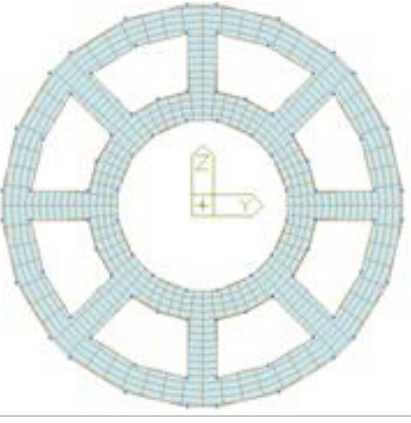
Figure 16. Fiber discretization of the chimney base section.